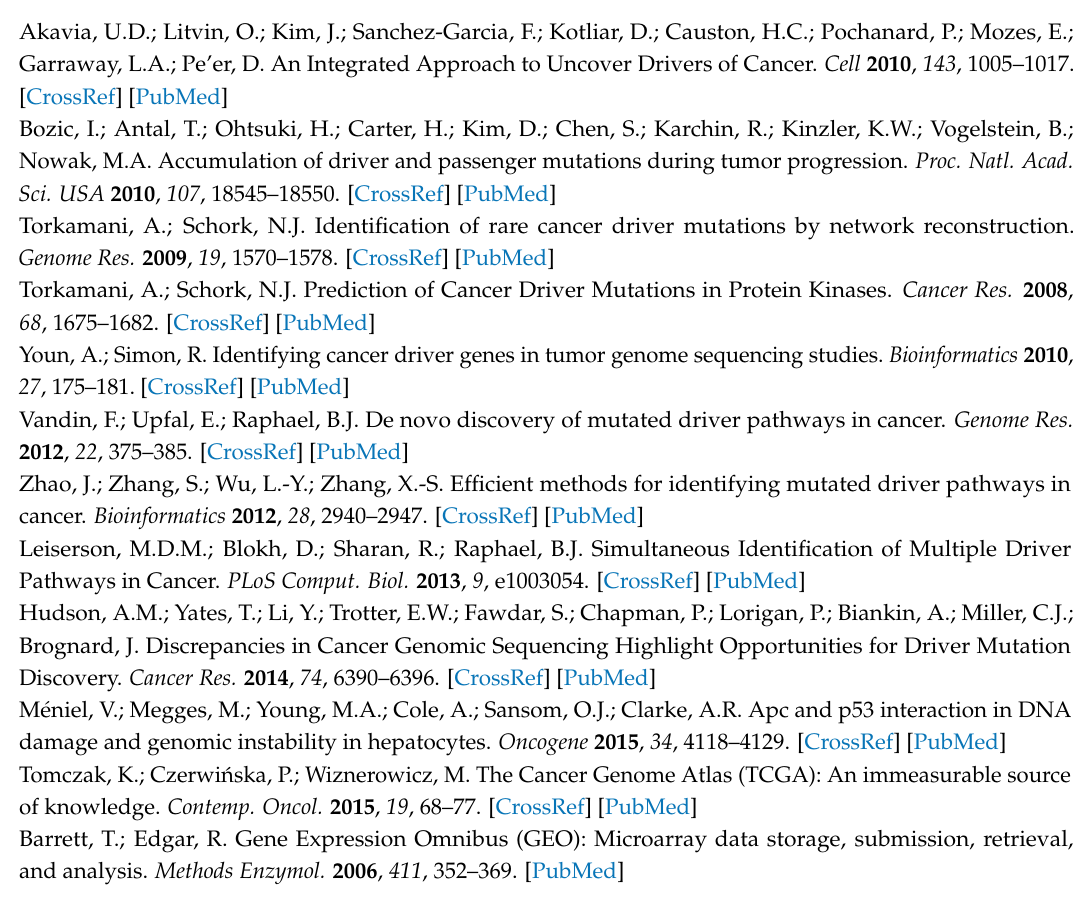
Figure S6: Overlap of fitness cores identified under different fitness networks in COAD and SKCM. Figure S7: A concise exhibition of functional relationships among top mutated driver genes for SKCM. Table S1: Fitness core for each case-background-network combination. Table S2: Absolute coverage of fitness cores. Table S3: Relative coverage of fitness cores Table S4: Functional and therapeutic implications of core genes in COAD. Table S5: Functional and therapeutic implications of core genes in SKCM. Table S6: Fitness relationships common in FNs for COAD with corresponding